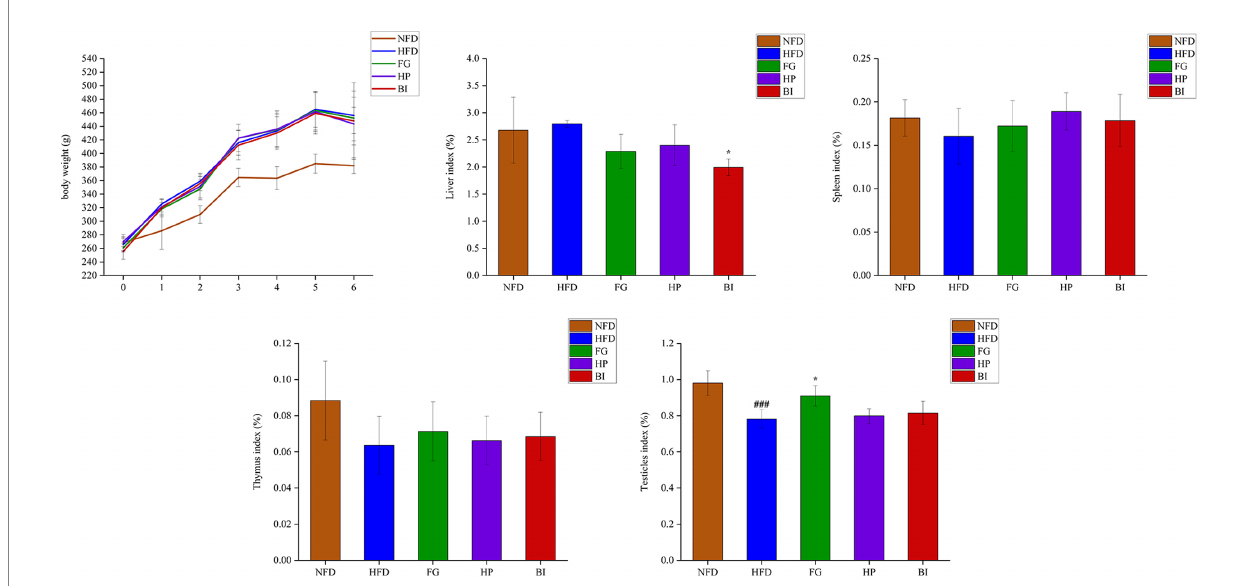
FIGURE 1 Effects of FG, HP, and BI treatment on body-weight and organ index on HFD-fed rats. The body weight, liver index, spleen index, thymus index, testicles index were shown, Values were expressed as mean ± SD in each group ( n = 6). Significantly different from NFD group, ### p < 0.001. Significantly different from HFD group, * p <